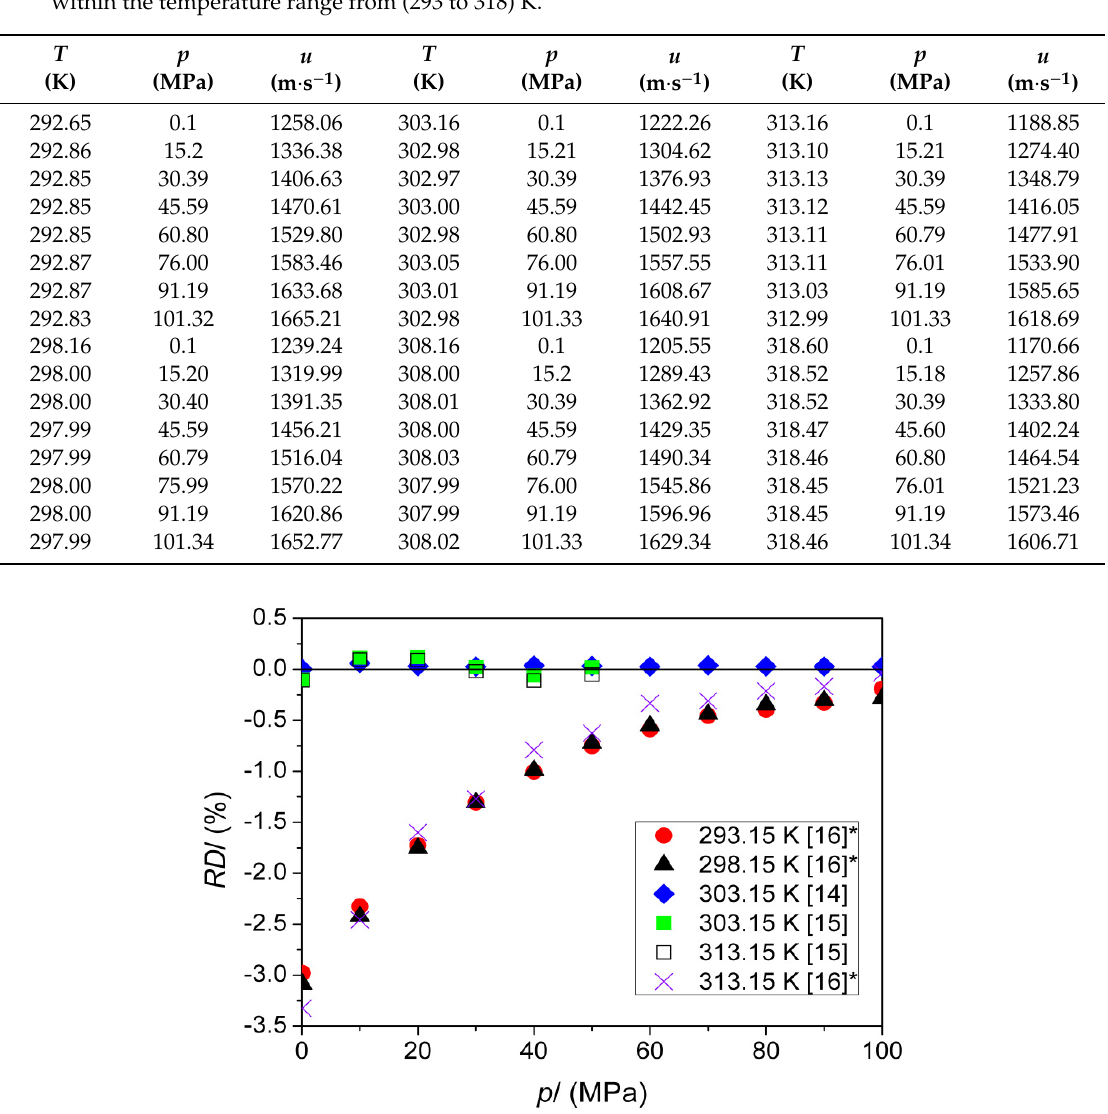
Figure 3. Comparison of the speed of sound in 1-butanol as a function of pressure obtained in this work ( u this work ) with the literature values ( u lit ) [14–16] presented as relative deviations RD s ( RD /% = 100 · ( u this work − u lit ) / u this work ); * calculated from the p ρ T data [16].